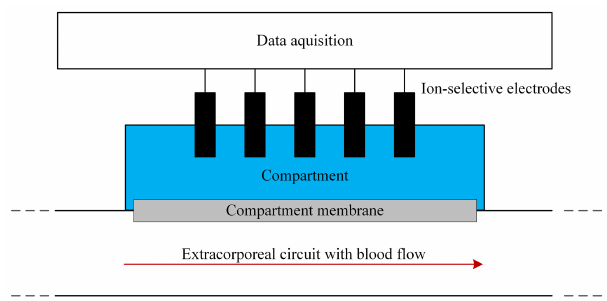
Figure 1. Schematic of the in-line concept for measuring blood pa- rameters using ISEs in a liquid-filled sensor compartment separated from the blood flow in the extracorporeal circuit by a dialysis mem- brane.